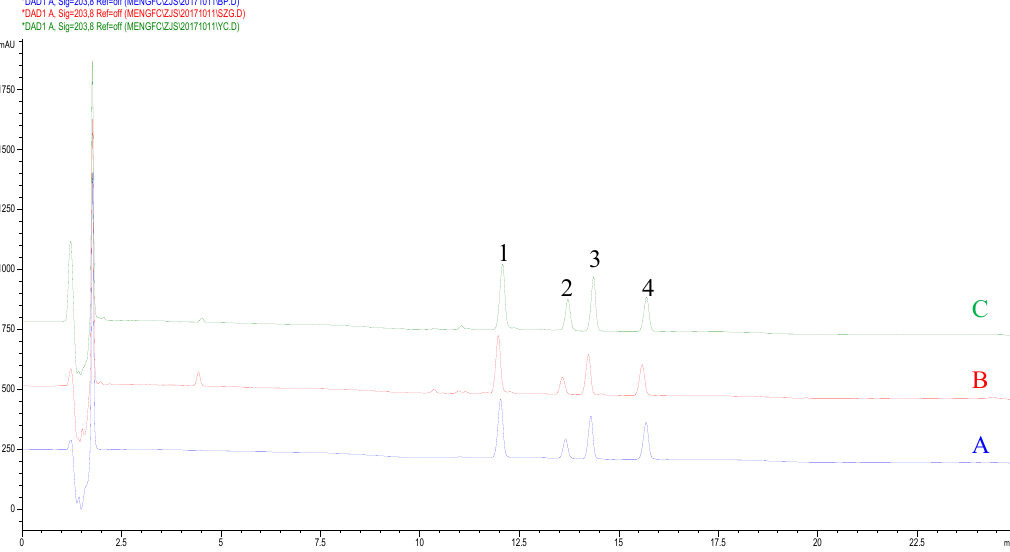
Figure 2. The HPLC chromatogram of ( A ) mixed standard references; ( B ) standardized reference fraction-TPJS; and ( C ) PJR-sample 1. 1: CS-V; 2: PG-RT1; 3: CS-IV; 4: CS-IVa. Table 3. Comparison of the contents (%) in PJR calculated by individual (M1) and TPJS cailbration curves